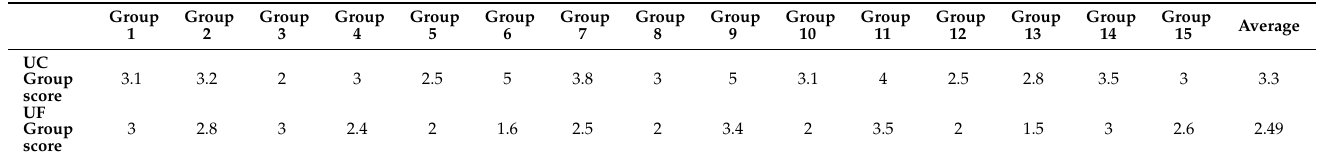
Table 6. UC and UF group